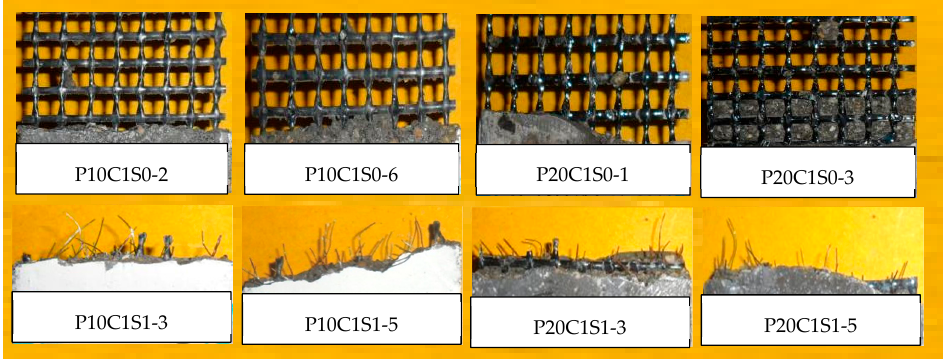
Figure 21. Fracture morphology of prestressed TRM specimens with one-layer textile.